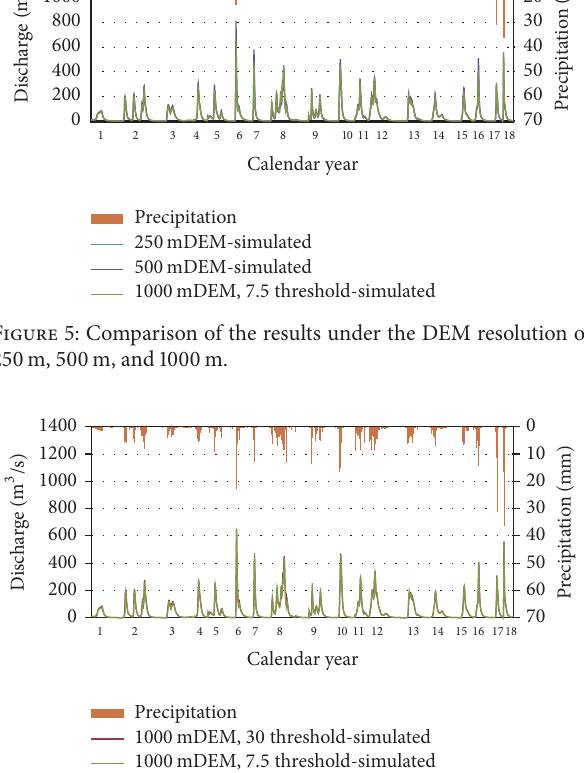
Figure 6: Comparison of the results under the channel thresholds of 7.5 and